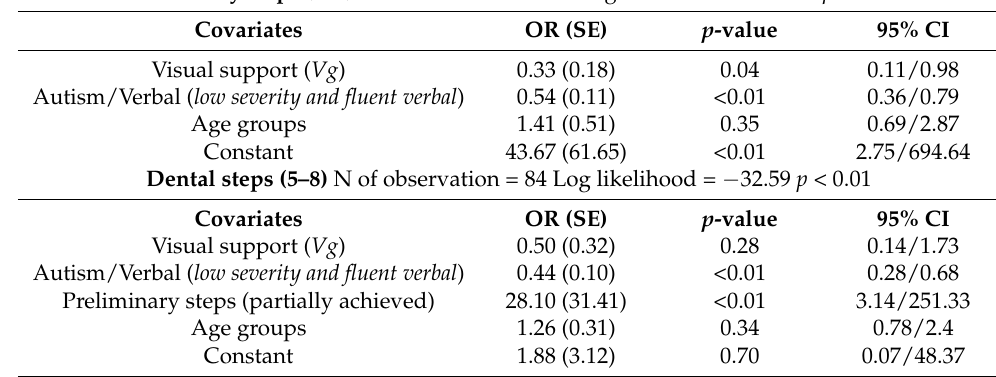
Table 5. Logistic estimates of achievements of preliminary or dental steps (multivariate logistic regression).